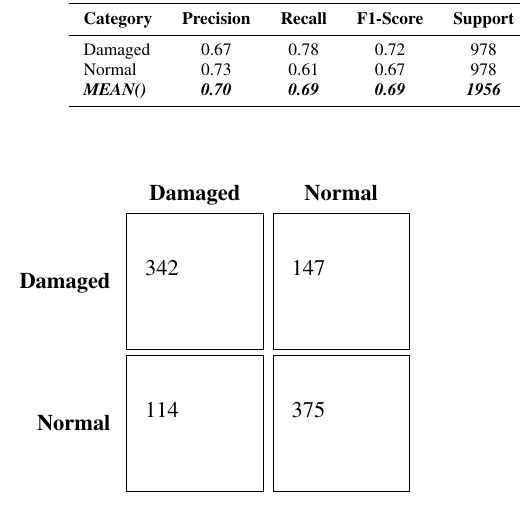
Table 4. Balanced Dataset with data augmentation (flipped images)